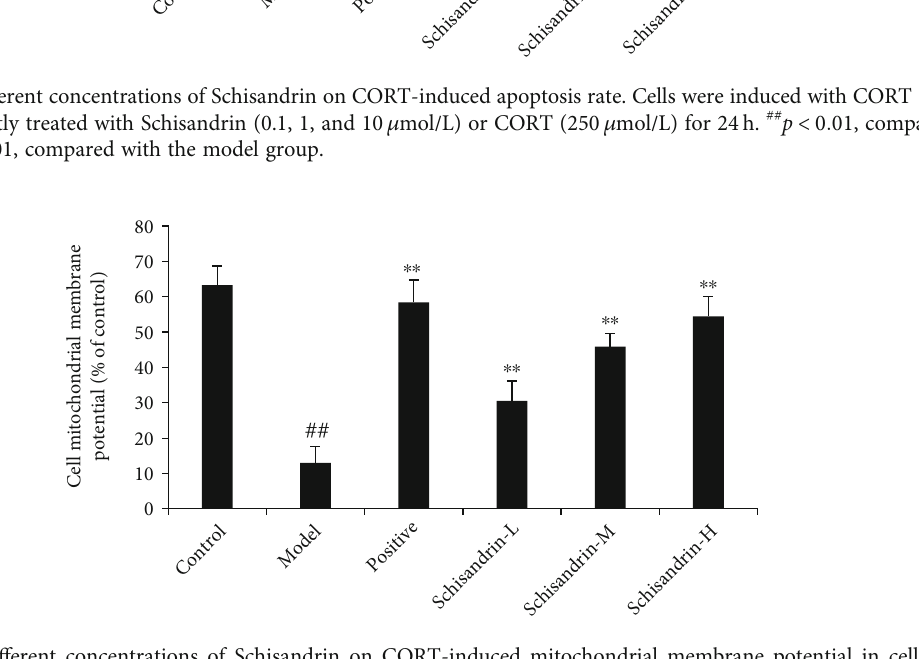
Figure 5: E ff ects of di ff erent concentrations of Schisandrin on CORT-induced mitochondrial membrane potential in cells. Cells were induced with CORT (250 μ mol/L) for 24 h and subsequently treated with Schisandrin (0.1, 1, and 10 μ mol/L) or CORT (250 μ mol/L) for 24h. ## p < 0 : 01 , compared with the control group; ∗∗ p < 0 : 01 , compared with the model